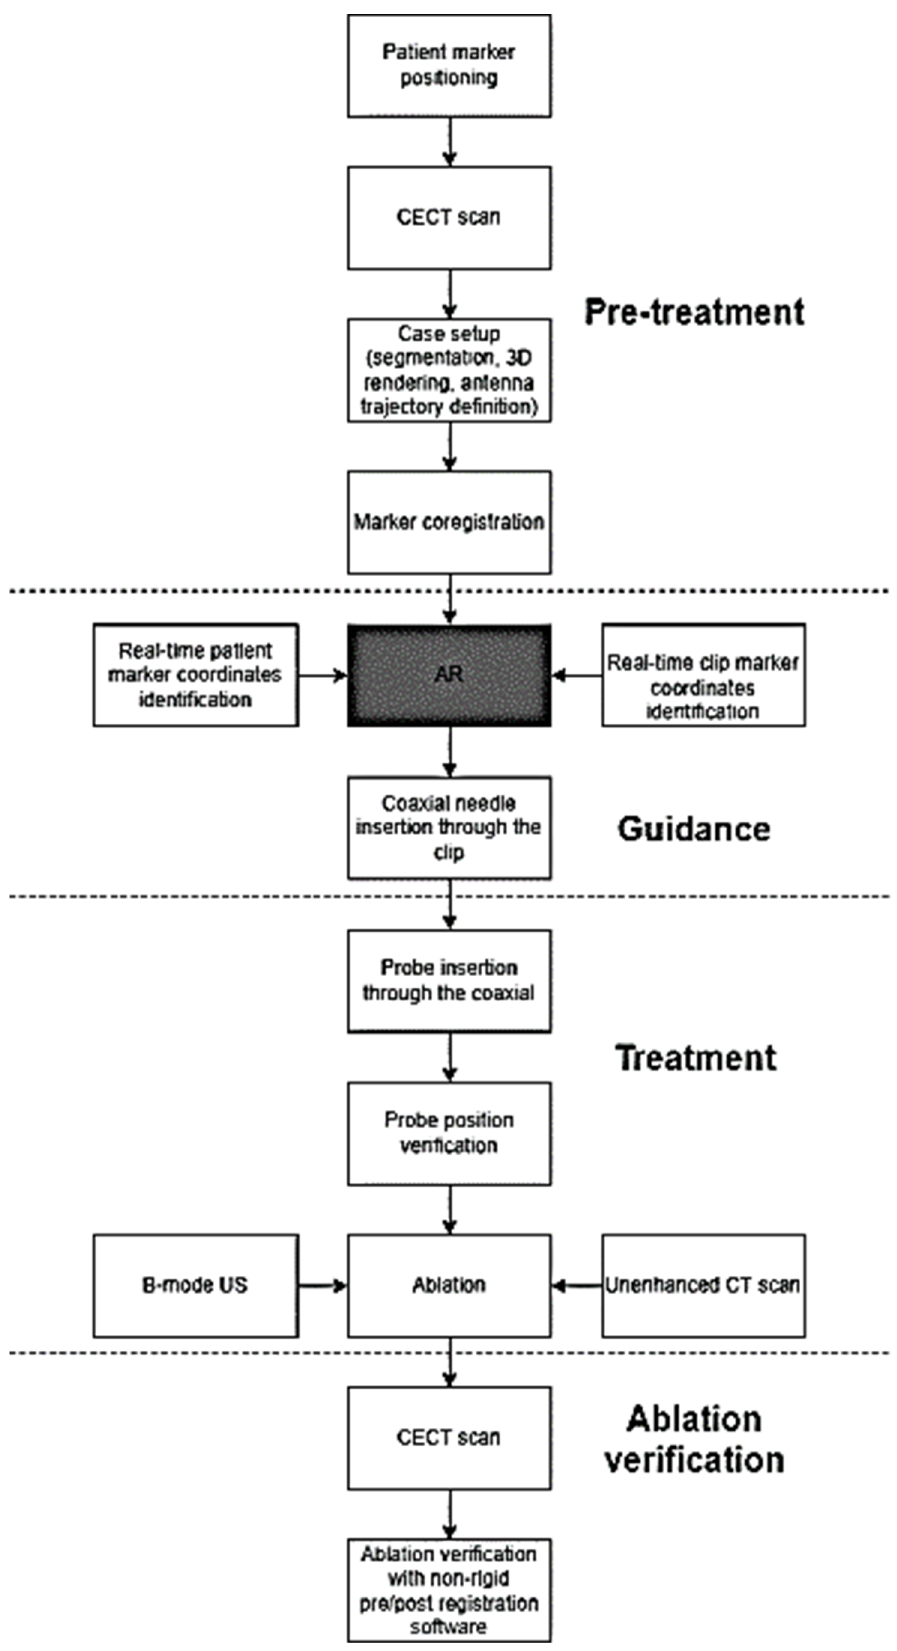
Figure 3. Workflow of the AR-guided thermal ablations.